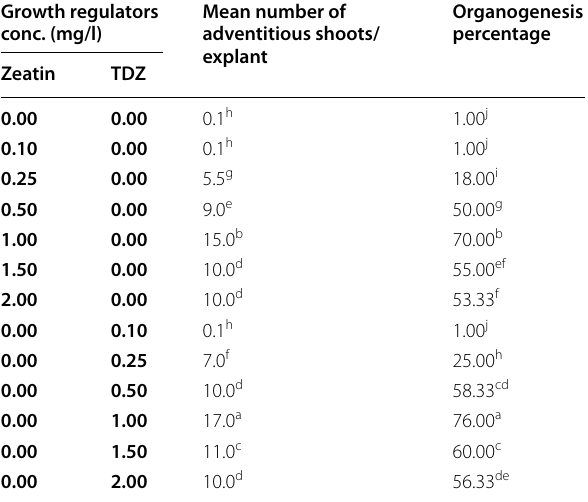
Table 3 Effect of Zeatin and TDZ at different concentrations on shoot regeneration from leaf of Dimocarpus longan